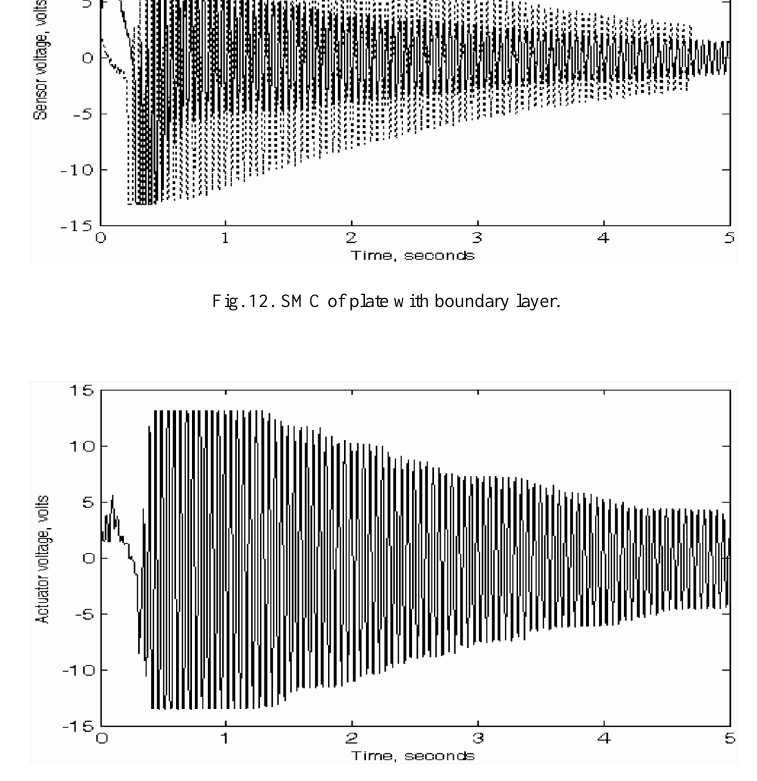
Fig. 13. Voltages applied on actuator when plate is controlled by SMC with boundary